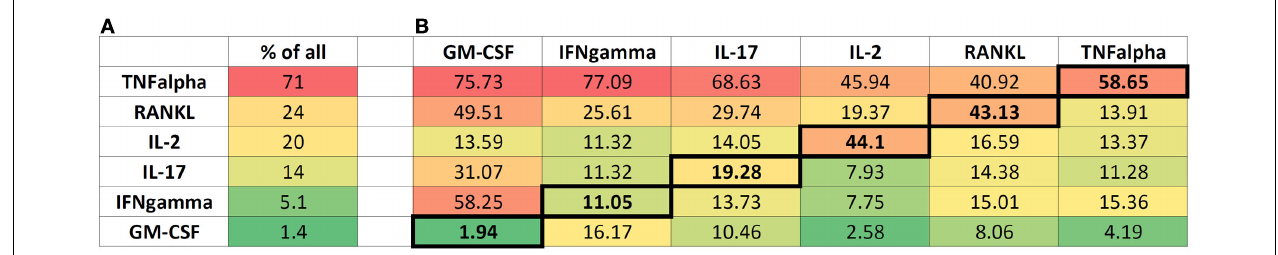
shown in (B) .The primary cytokines are listed from left to right as the column names. For each primary cytokine the percentage of cells co-expressing one of the other cytokines (listed as row names) are shown. As an example GM-CSF expressing cells often co-expressTNF- α (75.73% of all GM-CSF expressing cells) but only rarely IL-2 (13.59%). (Green background = low co-expression, red background = high co-expression).